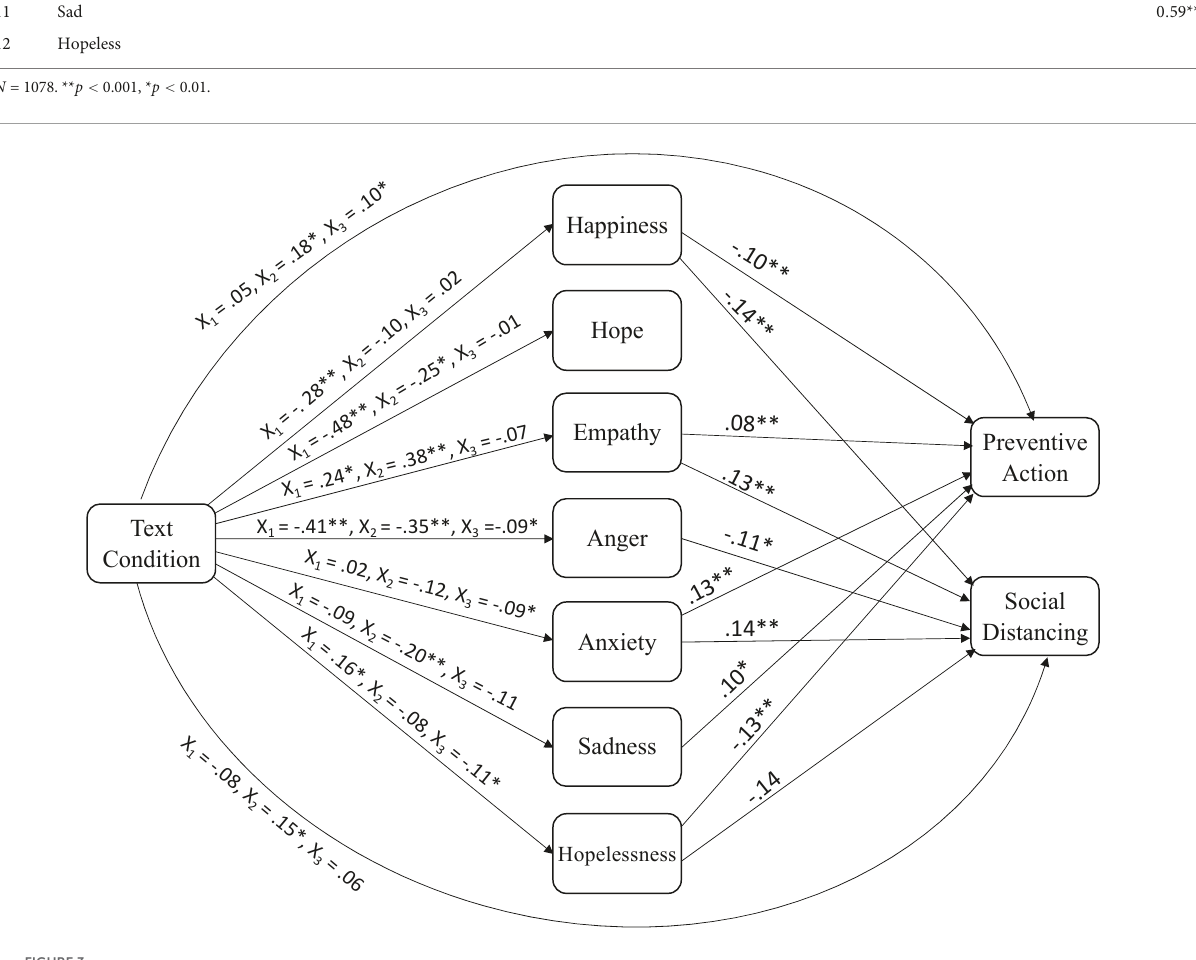
condition, t = 3.42, p < 0.001, d = 0.28. As hypothesized, the positive text significantly increased individuals’ engagement in preventive action 1 week following the intervention compared to the negative text condition and the control condition. In contrast, for engagement in social distancing and isolation,